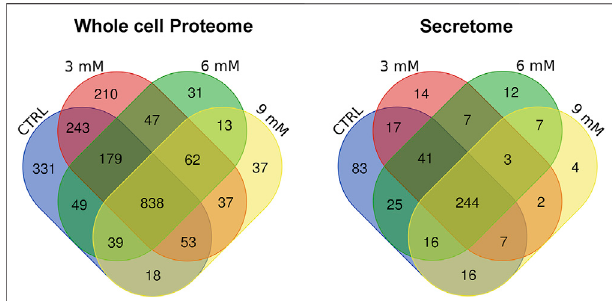
FIGURE 3 | Venn analysis of proteins found in cell lysates and secretomes. These pictures show the proteins that occur in all the experimental conditions (CTRL, 3, 6, and 9 mM metformin treatment), and those that are only present in some.